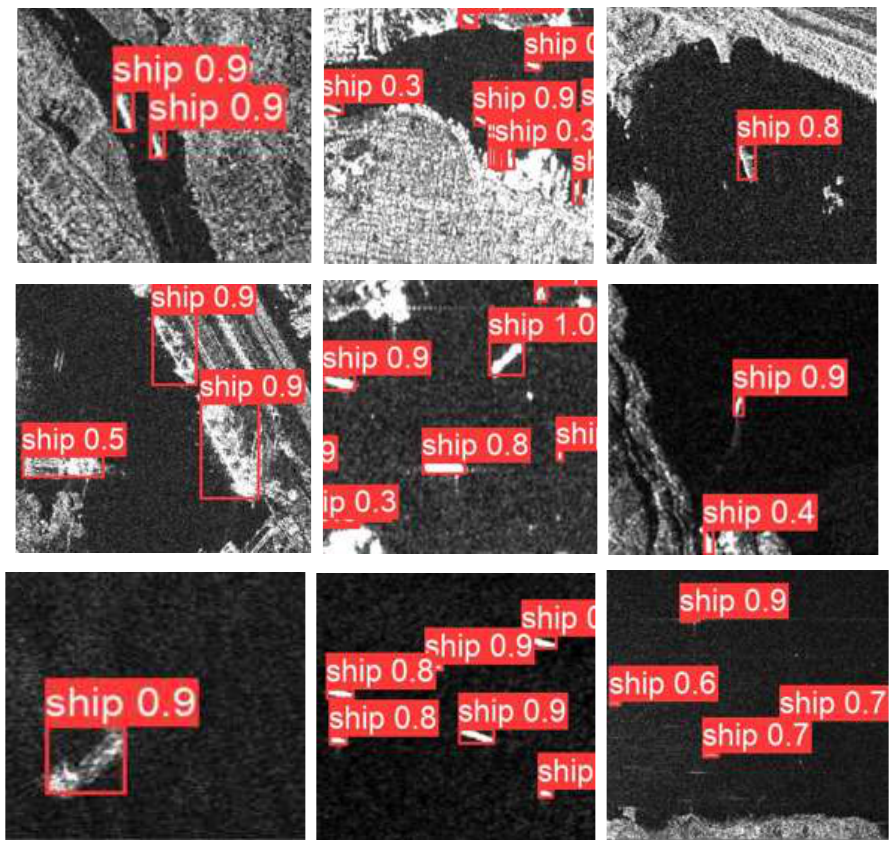
Figure 11. Visualization effect of our experiment on the SSDD dataset.